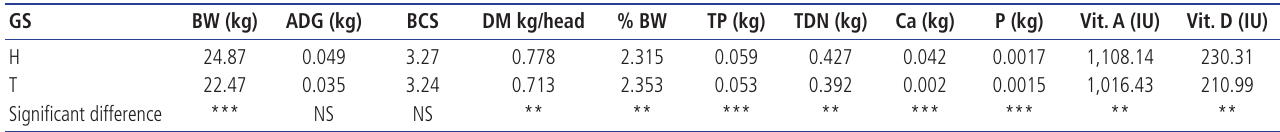
Table 4. Means of body weight, average daily gain and body condition score of goats accommodated on earth or slatted floors Parameter